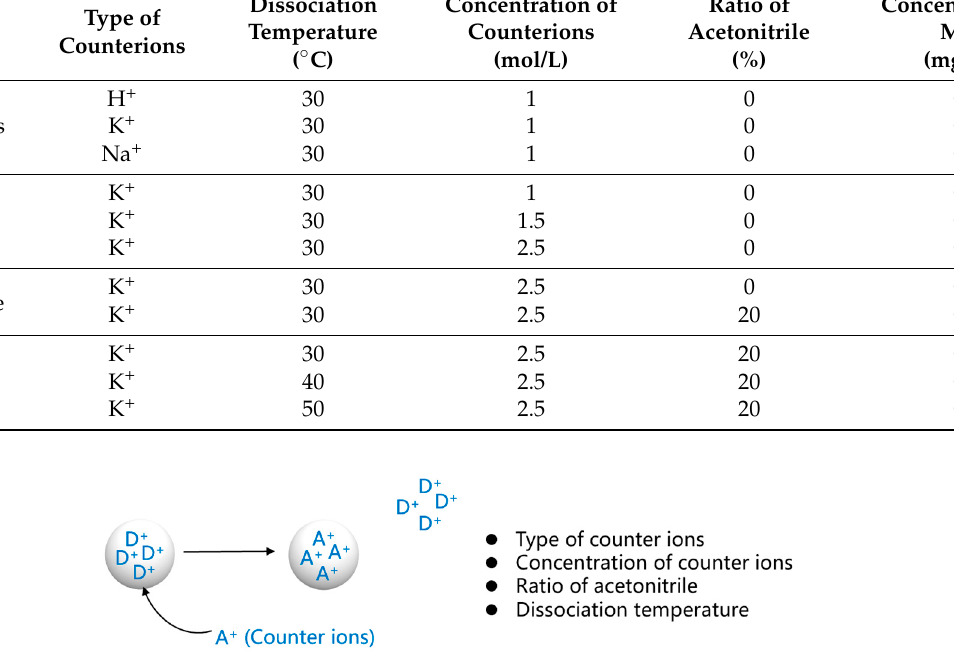
Figure 3. Study of factors affecting the dissociation process. (Where D + is the drug ions on the drug-resin complex and A + is the counter ions).